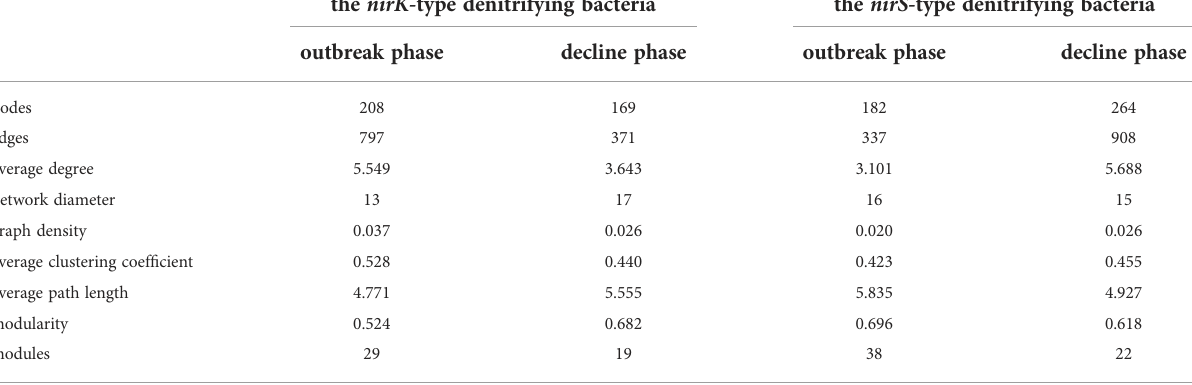
TABLE 2 Topological properties of the denitrifying bacterial co-occurrence networks during the green tide in coastal Qingdao areas. the nirK -type denitrifying bacteria